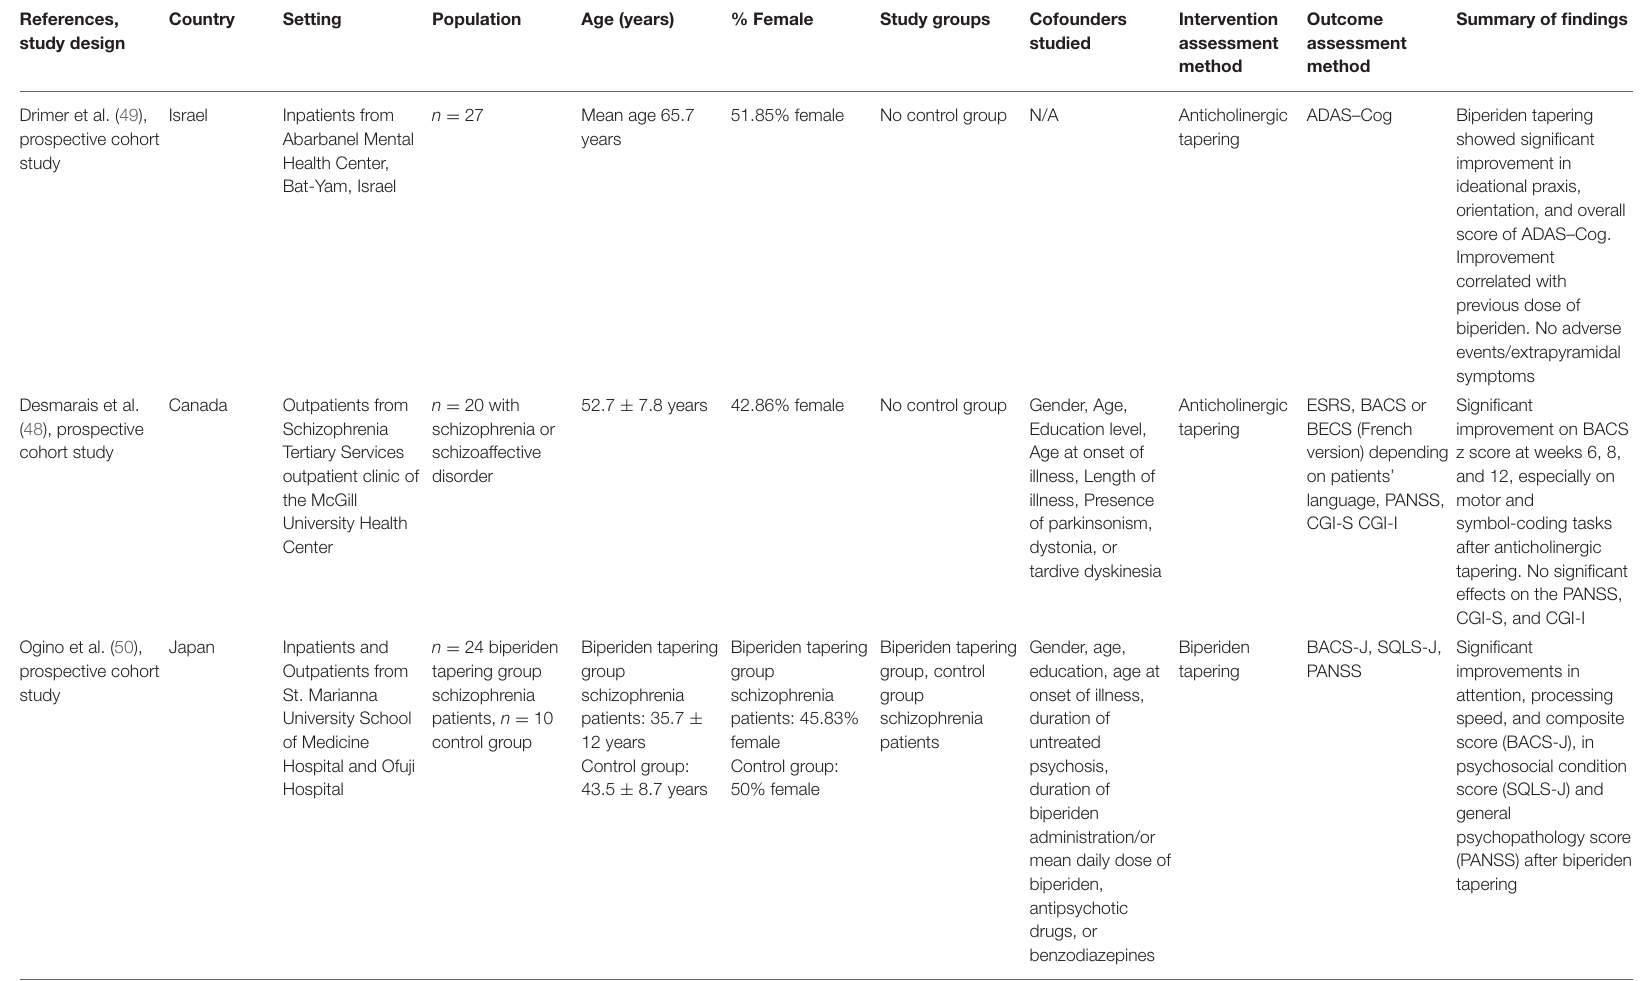
TABLE 1 | Qualitative analysis with the main characteristics of studies related to the influence of anticholinergic tapering on cognition in